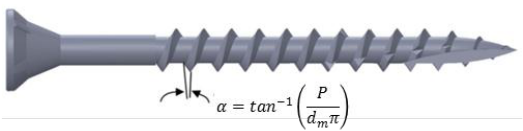
Figure 2. Screw thread spiral diagram.